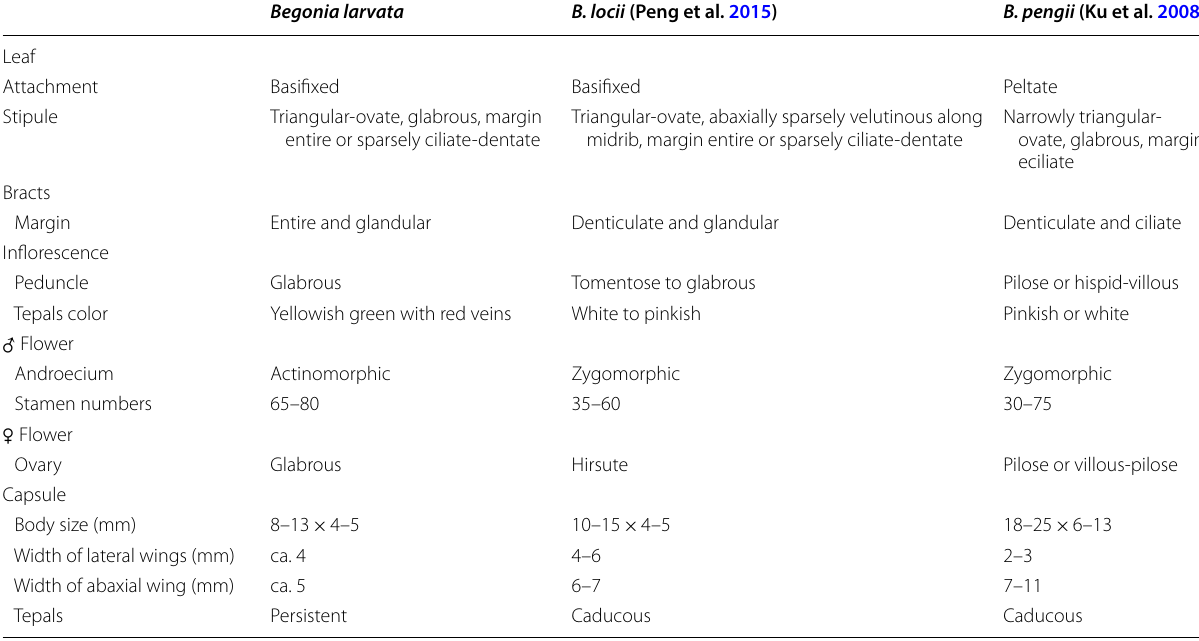
Table 1 Comparison of Begonia larvata with B. locii and B.